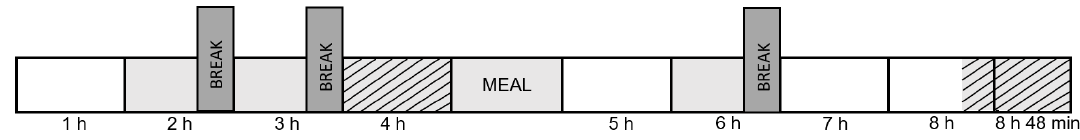
Figure 3. Distribution of the psychophysiological rest breaks in the 8 h 48 min shift.